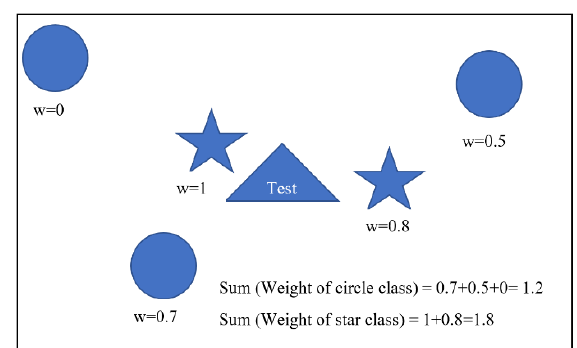
Fig. 1. Illustration of weighted kNN.